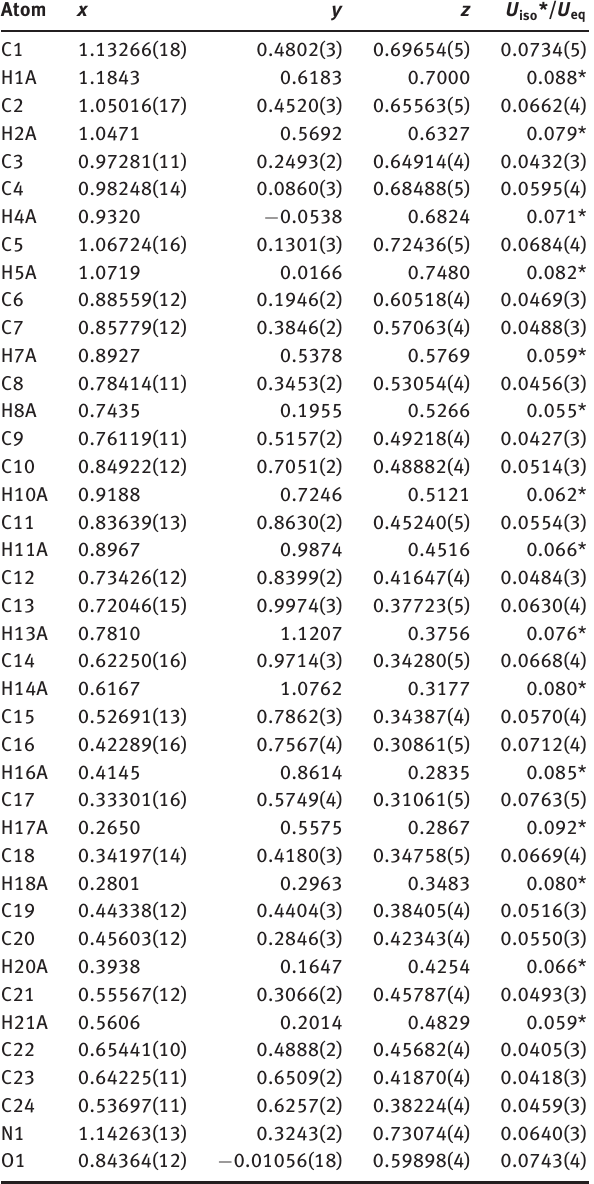
Table 2: Fractional atomic coordinates and isotropic or equivalent isotropic displacement parameters (Å 2